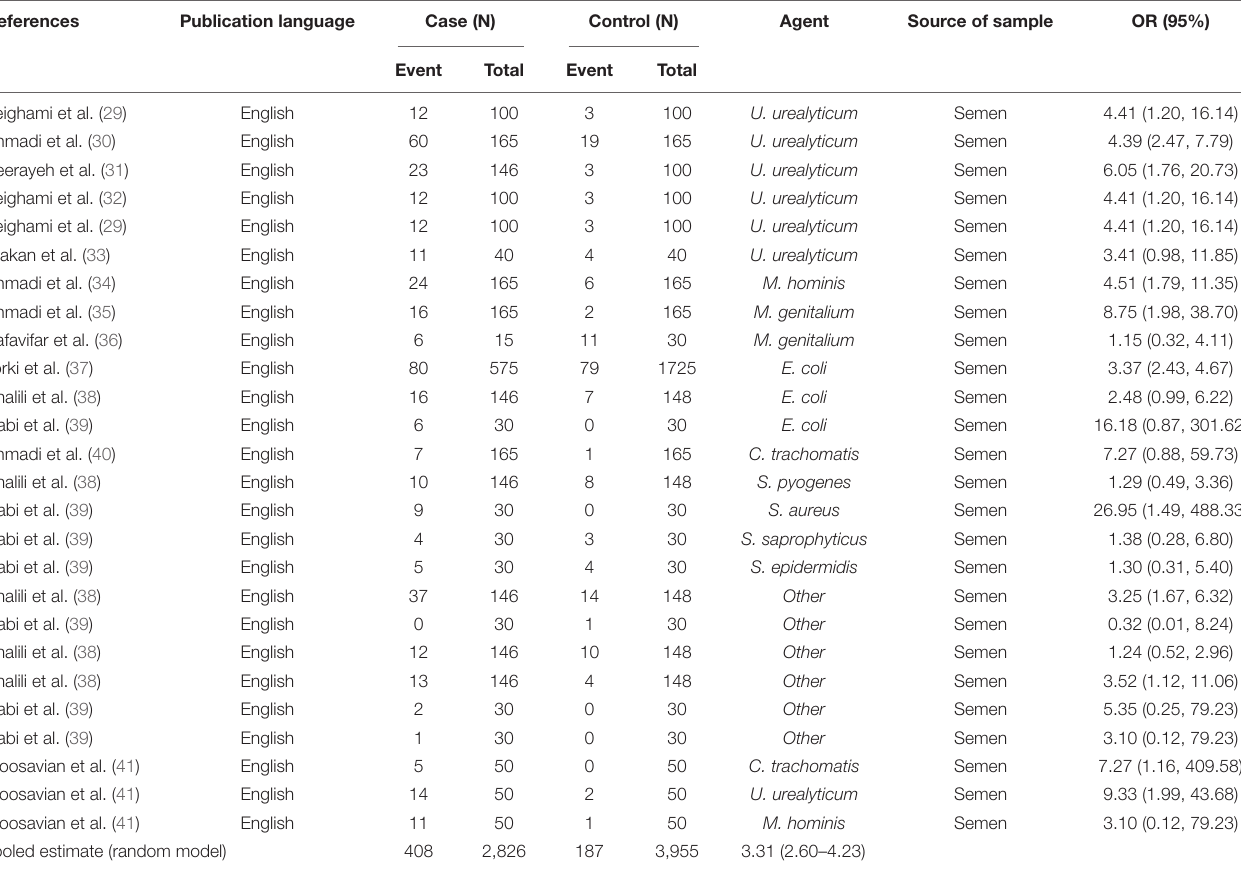
TABLE 3 | Case-control studies on bacteria included in the